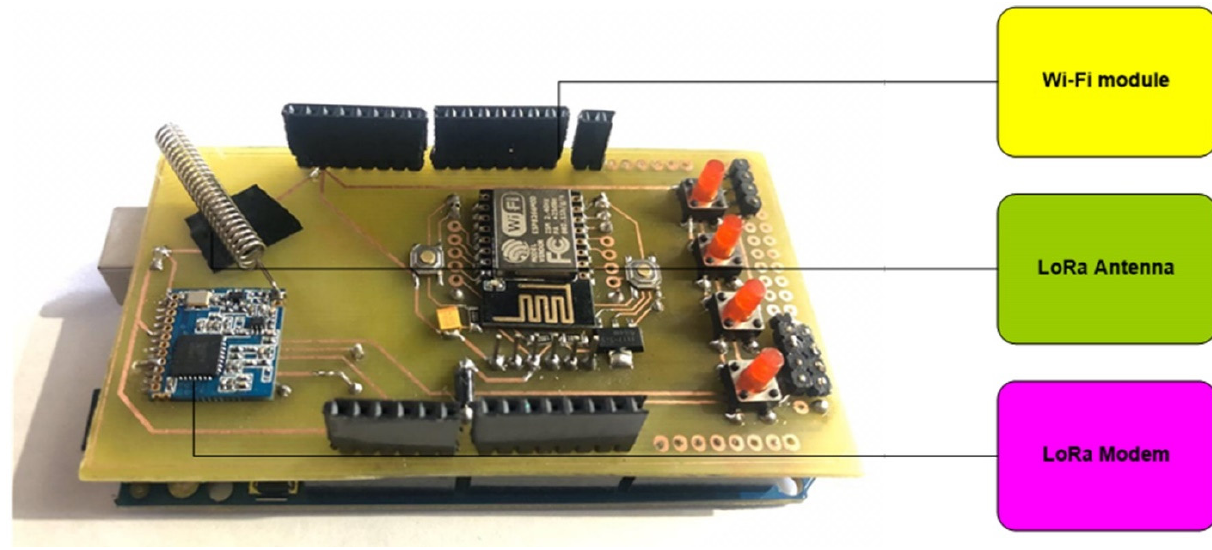
Figure 4. LoRa-based gateway.